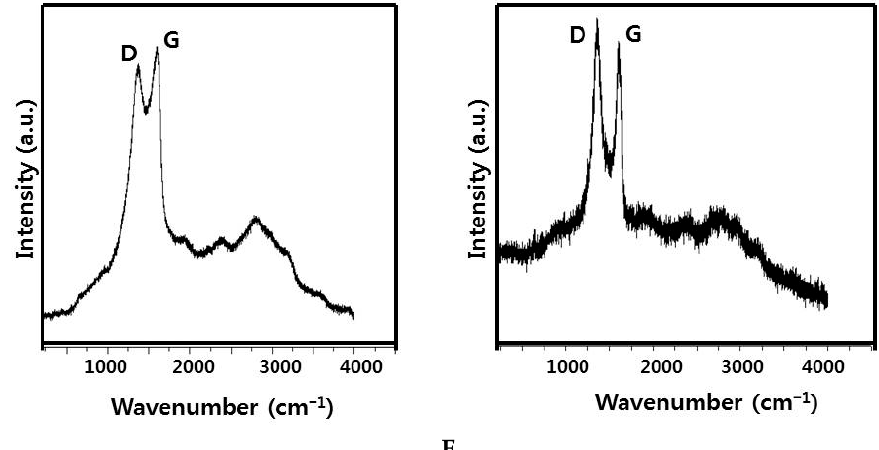
Figure 1. Synthesis and characterization of graphene oxide and graphene oxide–silver nanoparticle nanocomposite using lycopene. ( A ) Ultraviolet-visible spectroscopy of graphene oxide (GO) exhibit a maximum absorption peak at ~230 nm corresponding to the π – π transitions of aromatic C-C bonds. The absorption peak for GO-AgNPs exhibit peak at 230 nm and new peak at 410 nm is observed after deposition of AgNPs on the GO surface; the band at 410 nm in the absorption spectrum of the GO-AgNPs nanocomposite is attributed to surface plasmons and the presence of AgNPs; ( B ) X-ray diffraction (XRD) images of GO and GO-AgNPs; ( C ) scanning electron microscopy (SEM) images of GO and GO-AgNPs ( D ) Dynamic light-scattering (DLS) spectra of GO and GO-AgNPs dispersions. At least 200 particles were measured for each sample to obtain the size distribution; ( E ) transmission electron microscopy (TEM) images of GO and GO-AgNPs; ( F ) Raman spectroscopy images of GO and GO-AgNPs. At least three independent experiments were performed for each sample and reproducible results were obtained. The data present the results of a representative experiment.